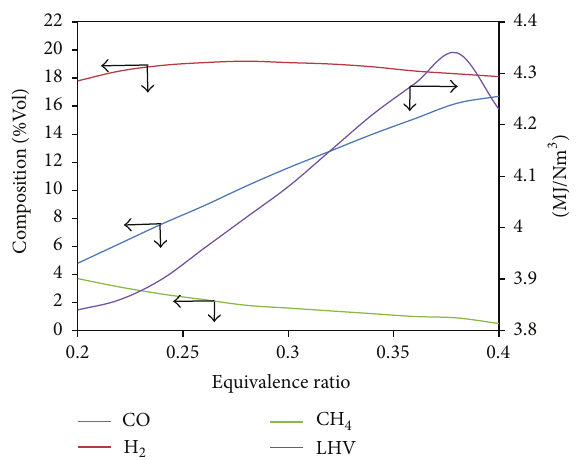
Figure 4: Combustible gas and LHV according to equivalence ratio at the maximum pyrolysis gas recirculation fraction.